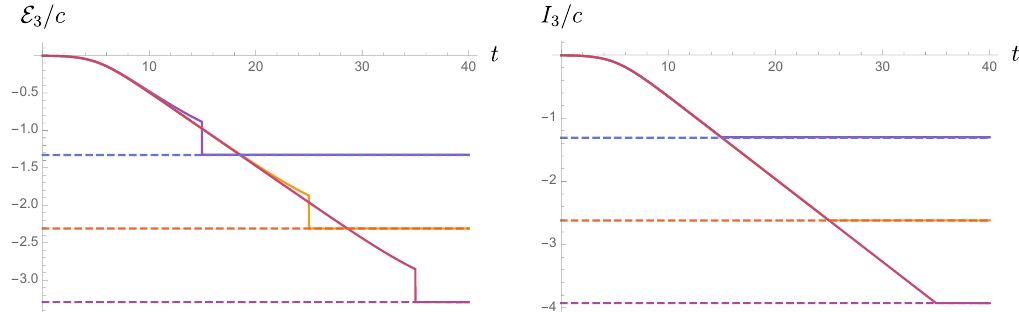
Figure 10 . (left) The tripartite operator negativity (3.34) is plotted for an input interval, A , of lengths 5 (magenta), 10 (yellow), 15 (purple). (right) TOMI (3.28) for the same con(cid:12)gurations. The dotted lines are the lower bounds given by (3.42).